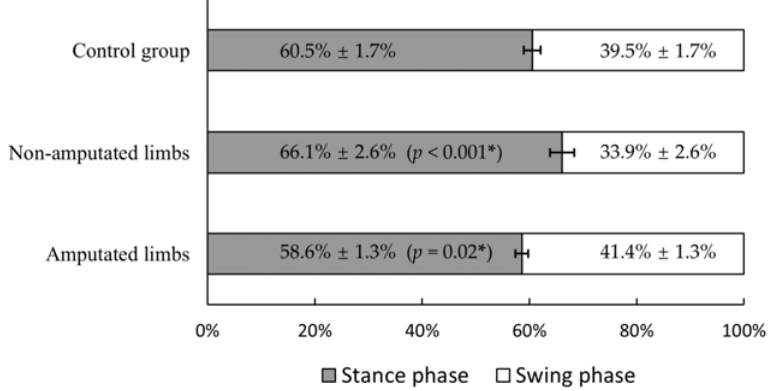
Figure 3. Duration ratio of the stance and swing phases for the amputees with amputated and non-amputated limbs and the able-bodied control group. Significance levels refer to t-test compared to the control group. * indicates a significant di ff erence relative to the control group ( p < 0.05).